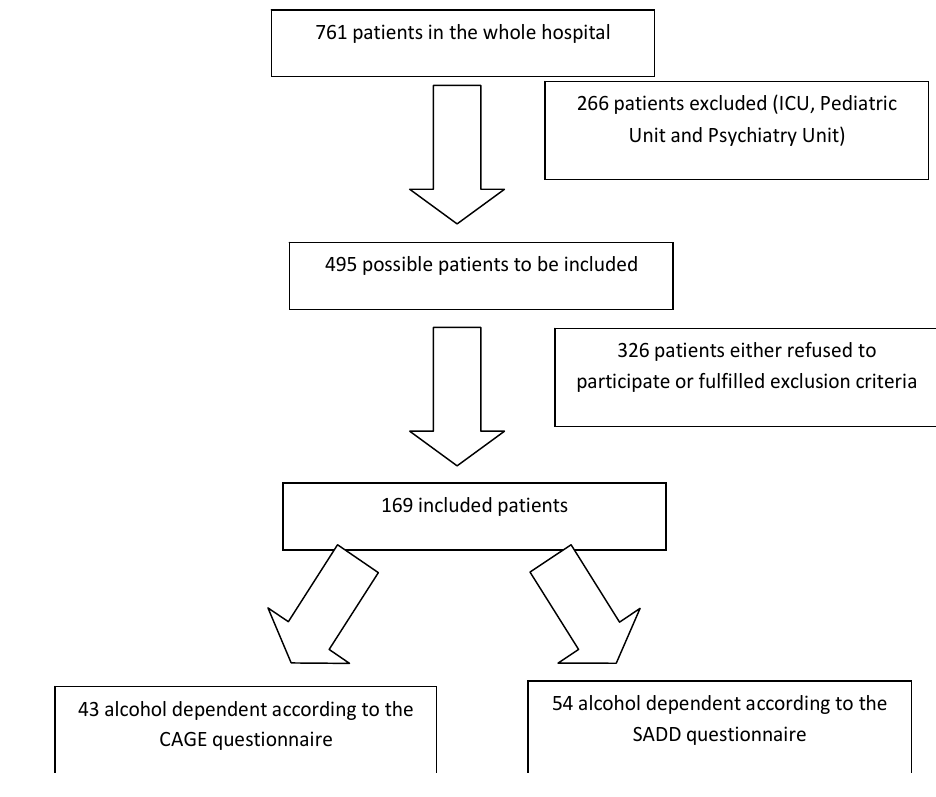
Figure 1. Flow chart describing patient